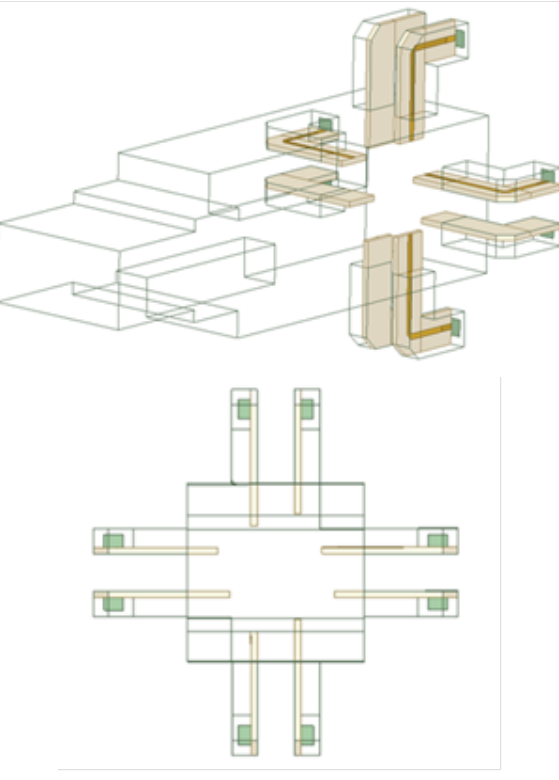
FIGURE 2. Transversal Probes Arrangement